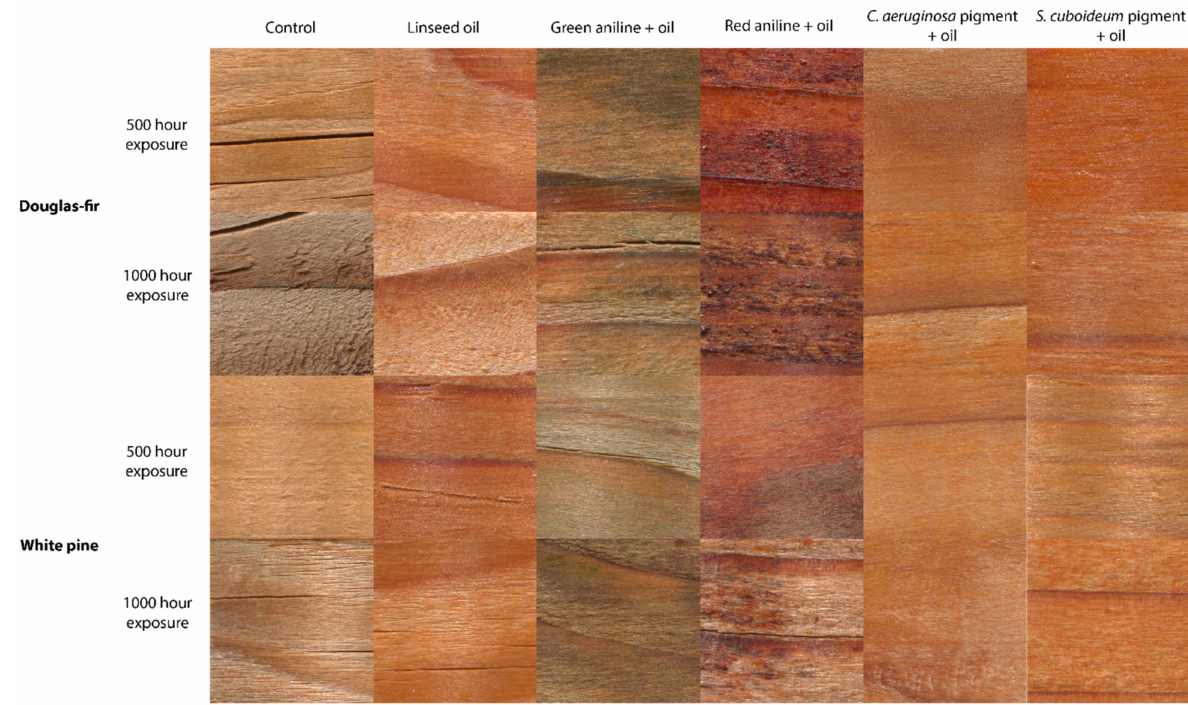
Figure 1. Samples of white pine and Douglas-fir with four different treatments after a weathering exposure of 500 and 1000 h.